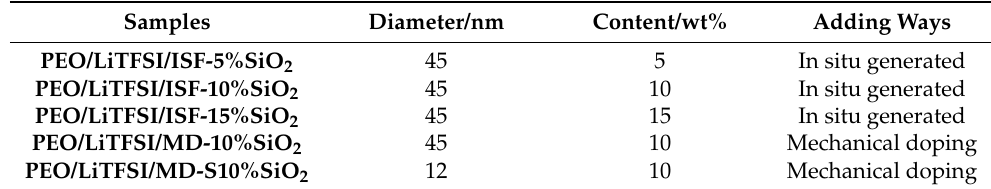
Table 1. A summary of the mass loading and adding ways of SiO 2 for the electrospun CPEs.